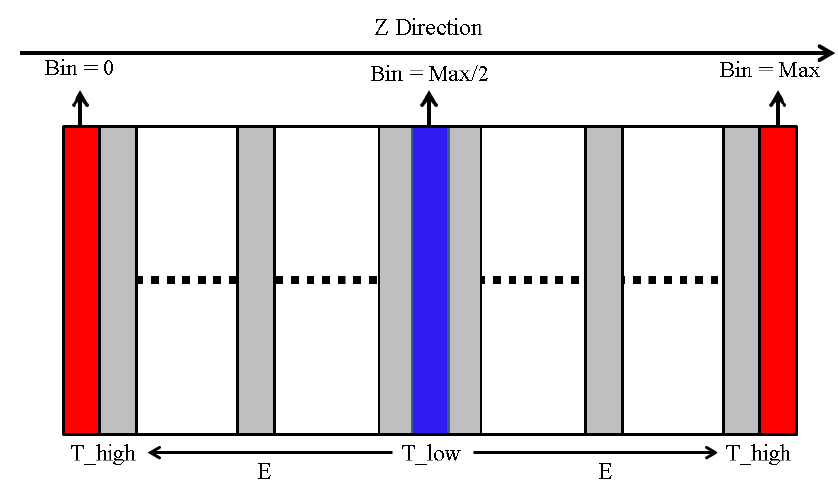
Figure 5. Geometric criteria for hydrogen bonds. D is the donor atom, H is hydrogen and A is the acceptor. DD is the donor antecedent and AA is the acceptor antecedent.